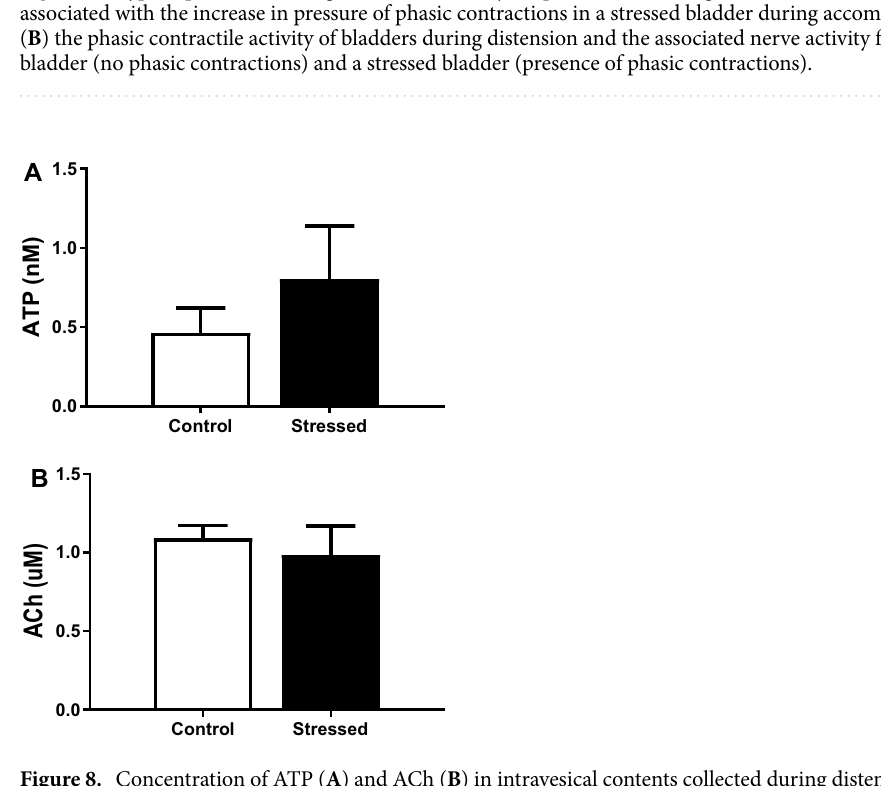
Figure 8. Concentration of ATP ( A ) and ACh ( B ) in intravesical contents collected during distension of control and stressed bladders. Data represented as mean ± SEM, n ≥